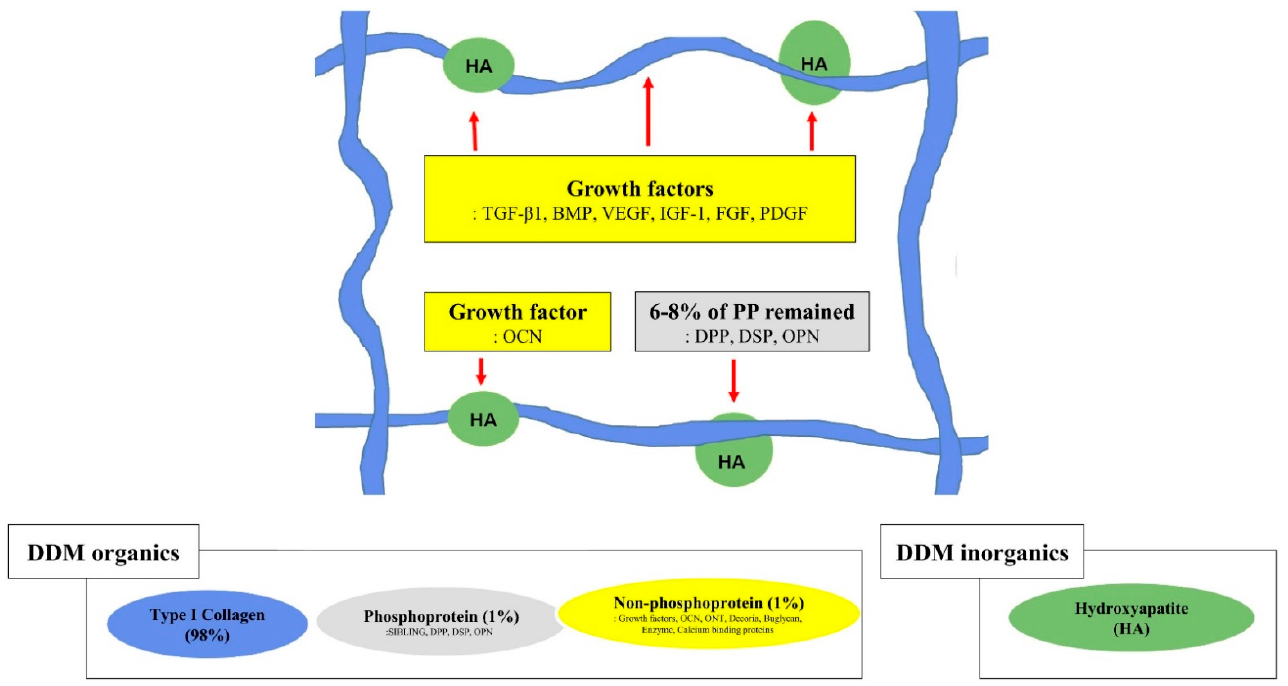
Figure 4. Graphical illustration of the structural relationships among the components of the extracellular matrix on demineralized dentin matrix [1,7,48]. Collagen and acid-insoluble non-collagenous protein networking. Type I collagen (in blue), hydroxyapatite (in green), non-phosphoprotein (in yellow), and phosphoprotein (in gray). The red arrow indicates hydroxyapatite binding; the red dotted arrow indicates collagen binding. SIBLING—small integrin-binding ligand, N-linked glycoprotein; DPP—dentin phosphoprotein; DSP—dentin sialoprotein; OPN—osteopontin; VEGF—vascular endothelial growth factor; BMP—bone morphogenetic protein; OCN—osteocalcin; IGF-1—insulin-like growth factor 1; FGF—fibroblast growth factor; PDGF—platelet-derived growth factor.